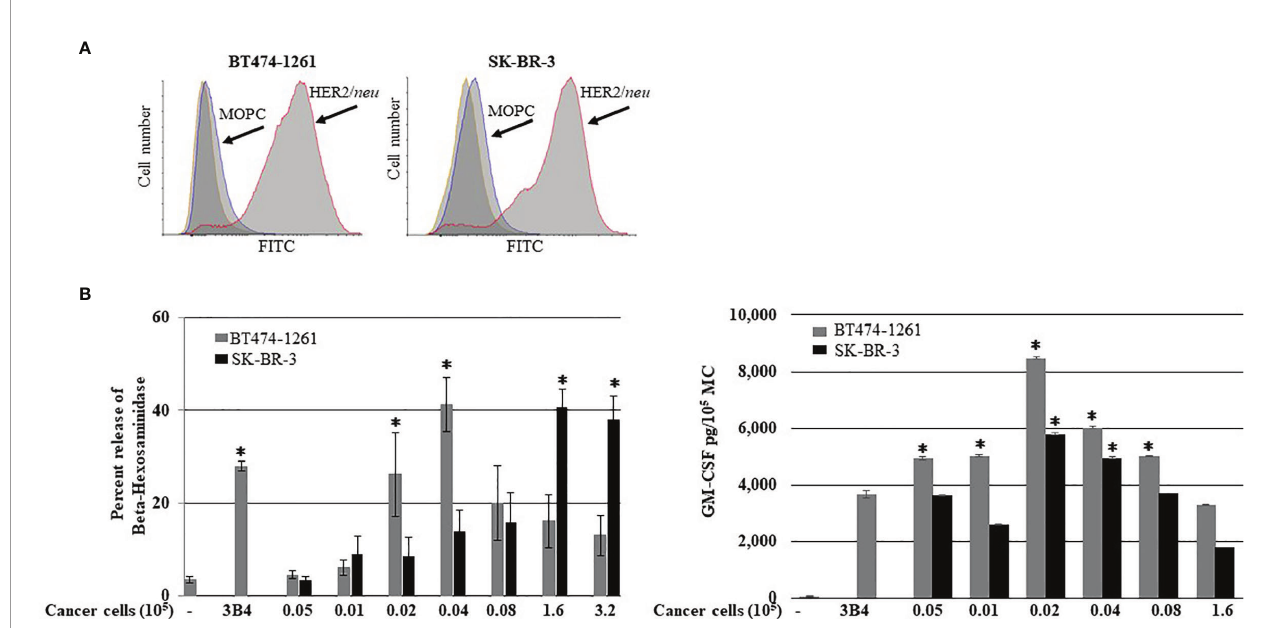
FIGURE 1 | Breast cancer cell-induced BDMC mediator release. (A) Expression of HER2/ neu on BT474-1261 or SK-BR-3 cells using FACS. BDMC were sensitized with 1 m g/ml anti-HER/ neu IgE washed, and incubated with fi ltered BT474-1261 or SK-BR-3 cells and degranulation ( B ; left) and cytokine release ( B ; right) assessed. Data are from a single experiment representative of experiments performed on cells derived from three separate donors. Error bars represent ±SD. * p <0.05 compared with non-IgE (spontaneous)